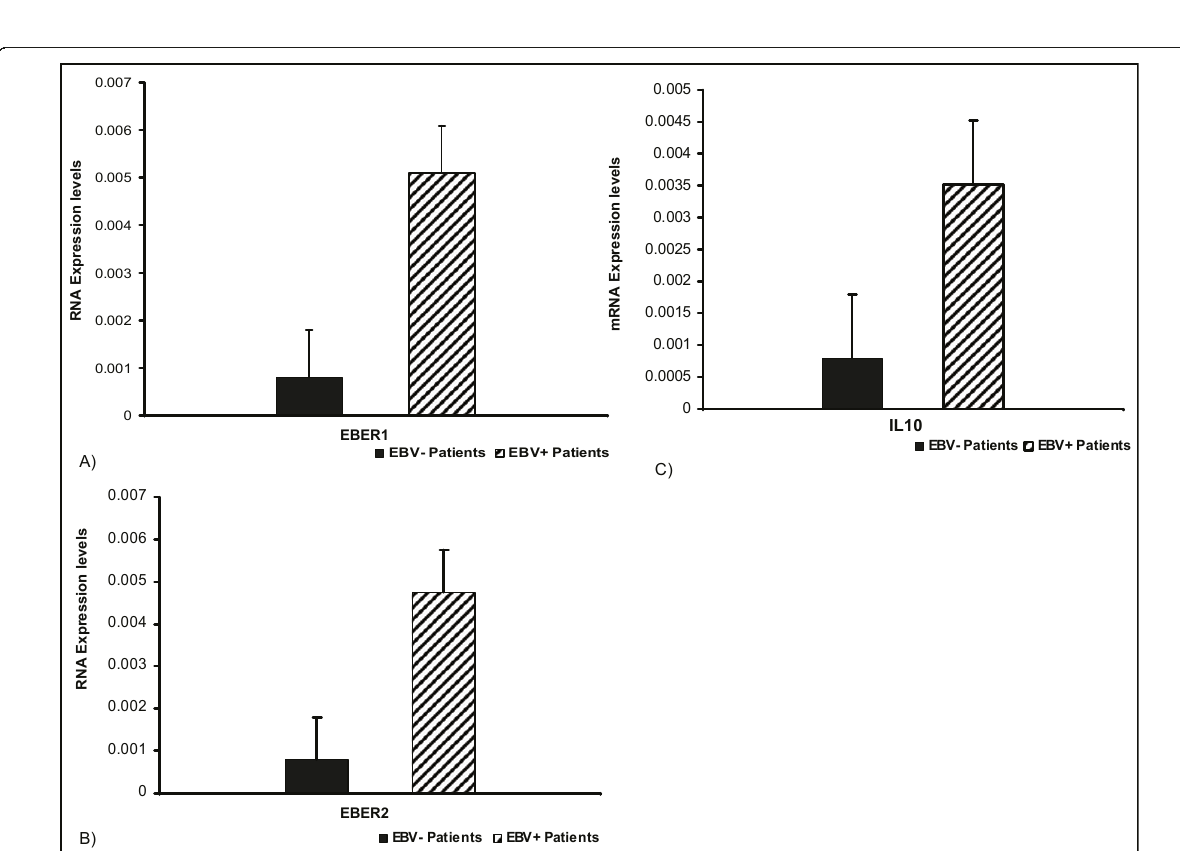
Figure 4 Real-time PCR based Quantitative analysis of EBER1, EBER2 and IL-10 transcripts : Real-time PCR was performed to determine the expression status of IL-10, EBER1 and EBER2. GAPDH was used as a reference gene to normalize expression of all samples. Expression levels of EBER1 (A), EBER2 (B) and IL-10(C) in EBV infected Burkitt ’ s lymphoma samples were quantified and compared to uninfected samples as negative controls. Data are shown after log